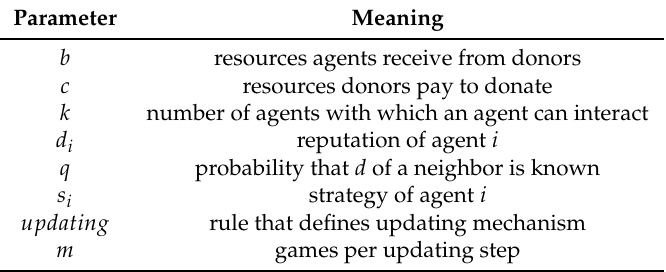
Table 2. Summary of all parameters in the